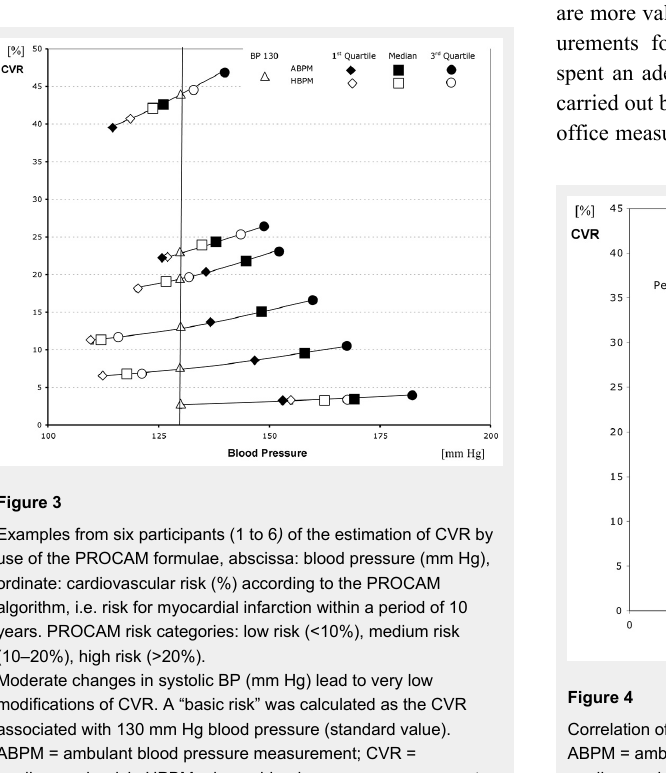
cardiovascular risk; HPBM = home blood pressure measurement